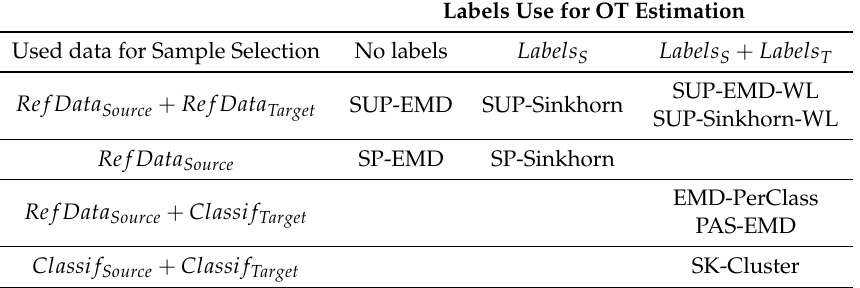
Table 3. The different proposed methods. The row indicates the used data for sample selection. The columns refer to how the labels are used in transport estimation. Labels come from source Labels S or target Labels T